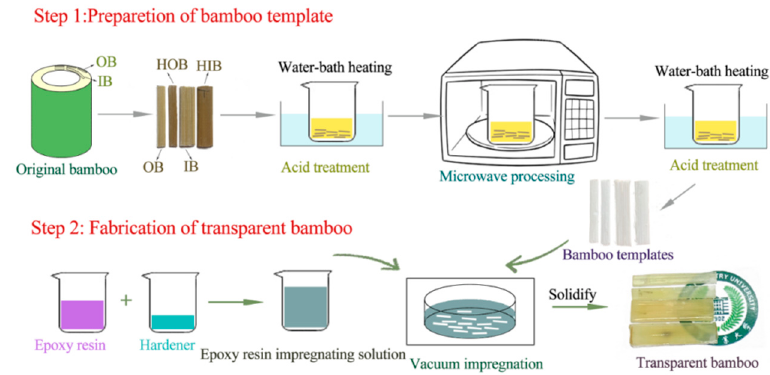
Figure 1. The main preparation process of transparent bamboo (TB).